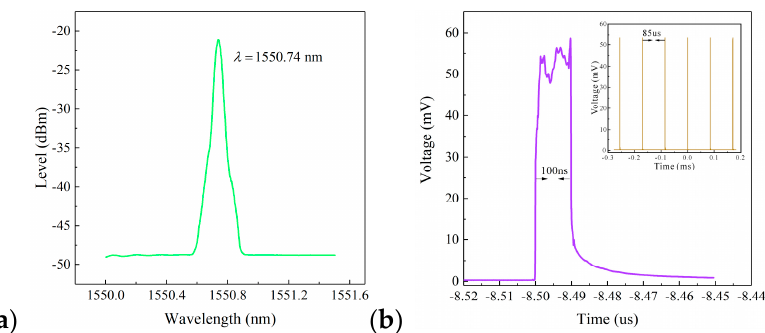
Figure 4. Characteristics of the generated optical pulse; ( a ) the pulse spectrum; ( b ) the pulse width and the repetition period.